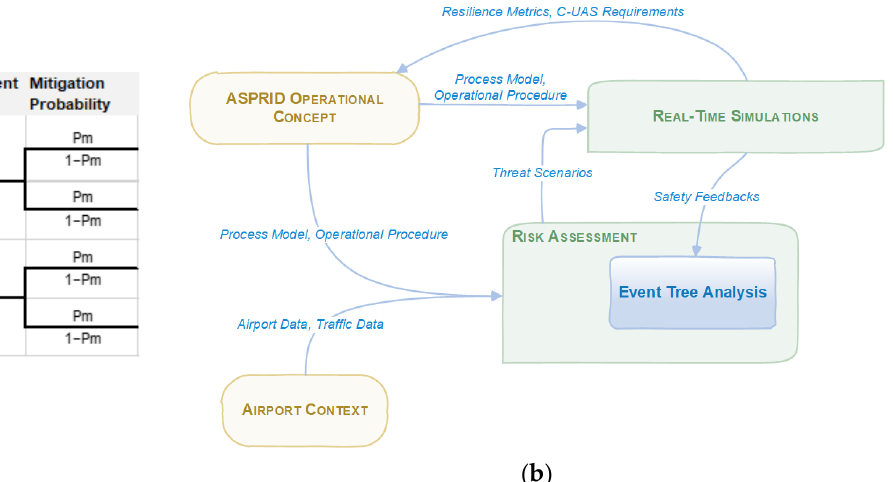
Figure 7. Evaluation approach. ( a ) Event tree for the assessment of threat scenarios [14]. ( b ) Evaluation workflow.